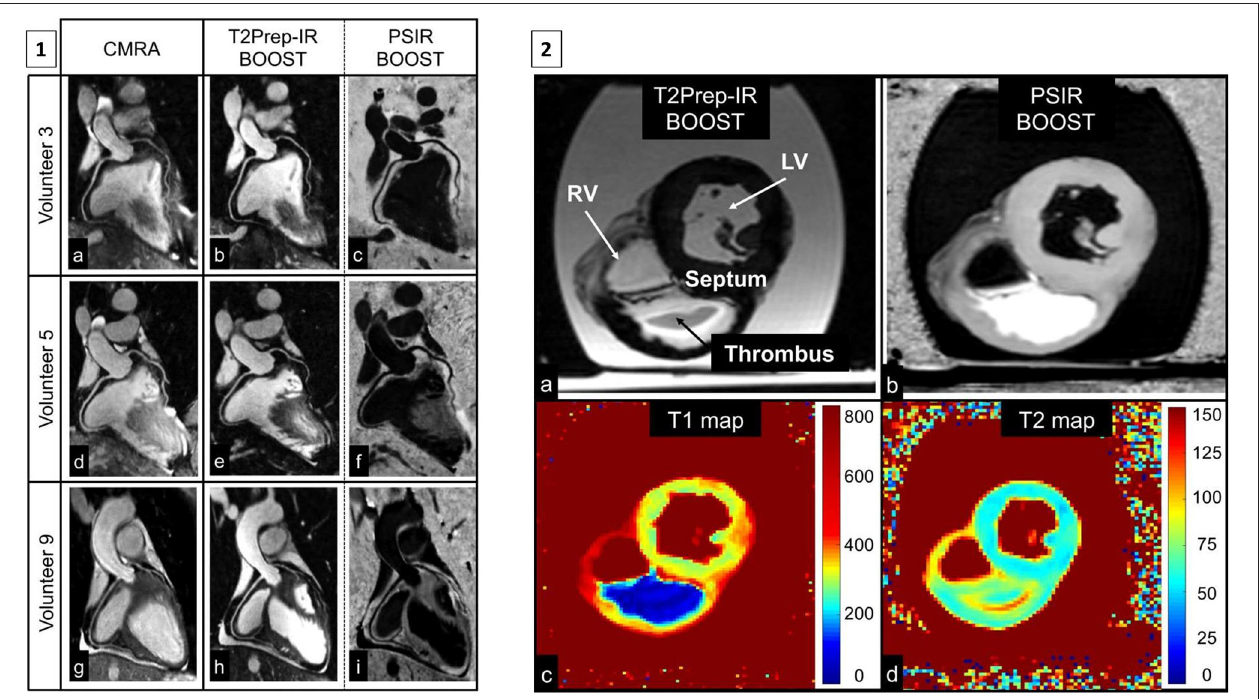
FIGURE 14 | ( 1 ) Reformatted coronary depiction in three representative healthy volunteers obtained with a conventional T 2 -prepared bright-blood CMRA acquisition (a, d, g) and the proposed BOOST sequence for simultaneous bright-blood (T 2 Prep-IR BOOST datasets in b, e, h) and black-blood (PSIR BOOST datasets in c, f, i) whole-heart MRI. Quantified CNR blood − myo significantly improved with the proposed T 2 Prep-IR BOOST approach in comparison to the conventional CMRA, thus leading to a higher quantified coronary percentage vessel sharpness (%VS) for both right and left coronary arteries. In the PSIR BOOST images in (c, f, i), the efficacy of blood signal suppression can be appreciated along multiple portions of the coronary tree. ( 2) MRI images obtained in the ex vivo pig heart. All the images depict a short-axis view at the midventricular level. Images acquired with the proposed BOOST sequence are reported in (a) (bright-blood T 2 Prep-IR dataset) and in (b) (black-blood PSIR-like reconstruction). RV, LV, thrombus, and interventricular septum are indicated. The black-blood reconstruction (b) clearly enhances the signal from the thrombus when compared to the bright-blood dataset (a). Furthermore, 2D T 1 (c) and T 2 (d) mapping techniques were acquired. The ex vivo thrombus is characterized by a relatively short T 1 and T 2 . BOOST, Bright-blood and black-blOOd phase SensiTive; IR, inversion recovery; myo, myocardium; PSIR, phase-sensitive inversion recovery; T 2 Prep, T 2 prepared; LV, left ventricular cavity; RV, right ventricular cavity. Adapted with permission from Ginami et al. (